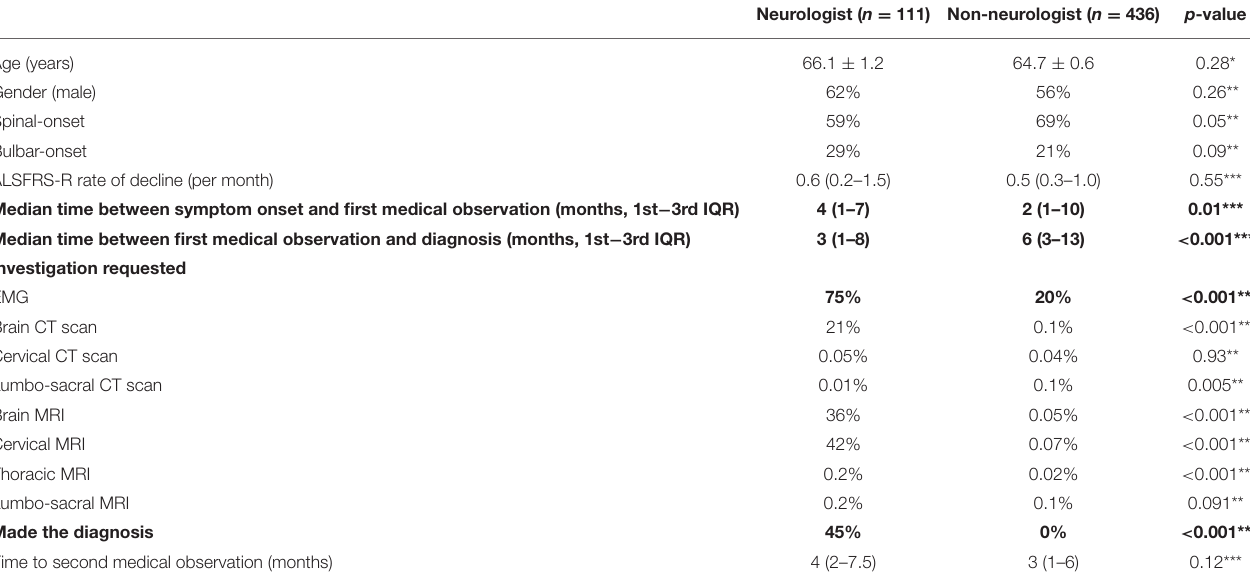
TABLE 3 | Comparison between ALS patients who were first observed by a neurologist and